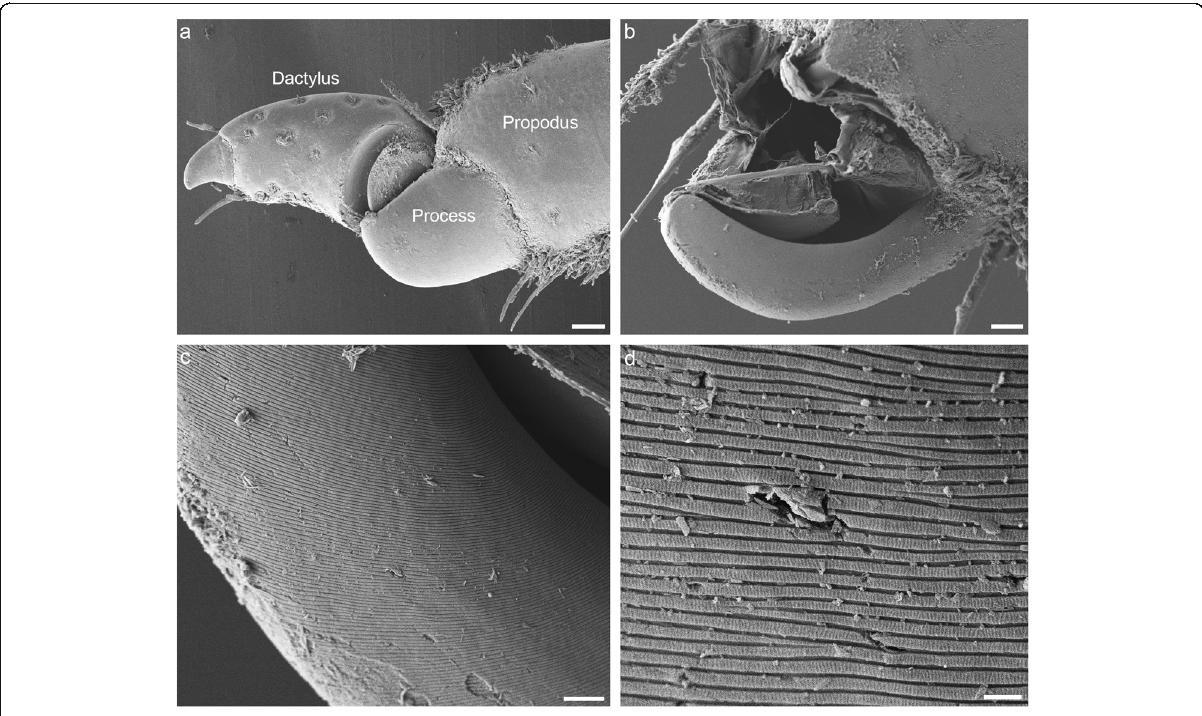
Fig. 10 Propodus-dactylus joint in Sphaeroma serratum. a Scanning electron micrograph of the joint between the propodus and the dactylus in the aquatic sphaeromatid S. serratum . The dorsal side of the pereopod is at the top of the image. The propodal process does not form a full semicircle. Its thick edge fits into a smooth, semicircular groove on the dactylus. b Propodal process with the dactylus removed. Its curved ventral edge is thickened. c Higher magnification of the thick edge. Its surface is patterned and forms parallel ridges. d Ridges on the propodal process in S. serratum appear flat and cross-striated. Particles are trapped in the grooves between them. Scale bars: 50 μ m (a), 20 μ m (b), 5 μ m (c), 1 μ m